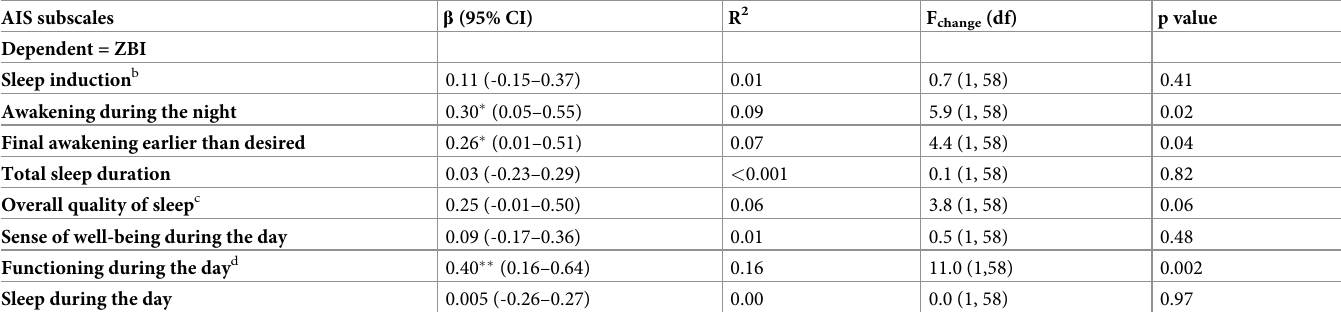
Table 4. Univariate regression analysis examining Athens Insomnia Scale predictors of Zarit Burden Interview score. (n = 60). AIS subscales β (95%